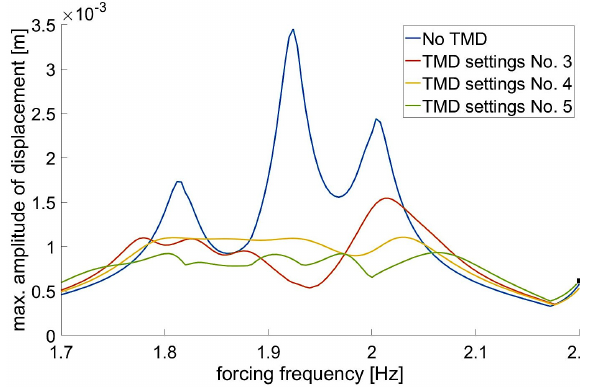
Figure 7. FRF - settings No. 3-5.